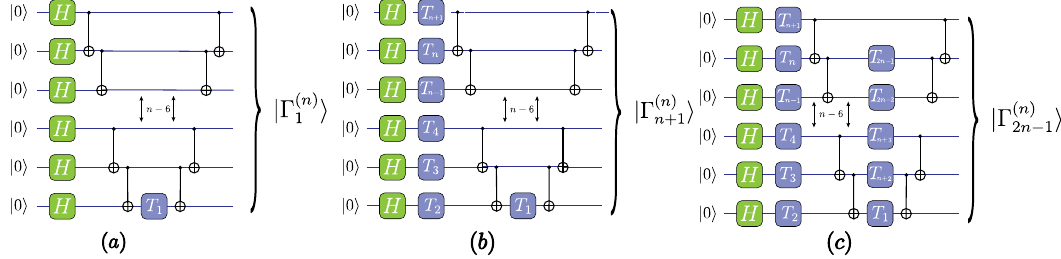
(cid:5) E (cid:5) (cid:5) Fig. 3 Preparation of Γ ð n Þ t -states. The magic seeds ( T -gates) are placed either on the fi rst layer (immediately after the Hadamard gates H ), or in the second layer (immediately after the fi rst layer of C − NOT gates). We start with a T -gate in the second layer, then start fi lling up the fi rst layer. Upon completion of the fi rst layer, we start fi lling up the second layer again. The fi gure shows: ð a Þ Γ ð n Þ